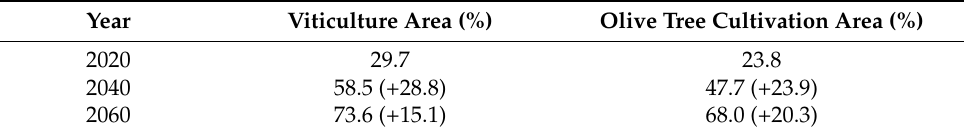
Table 5. The temporal variation of the percentage (%) of the research area, which is suitable for cultivation according to GDD